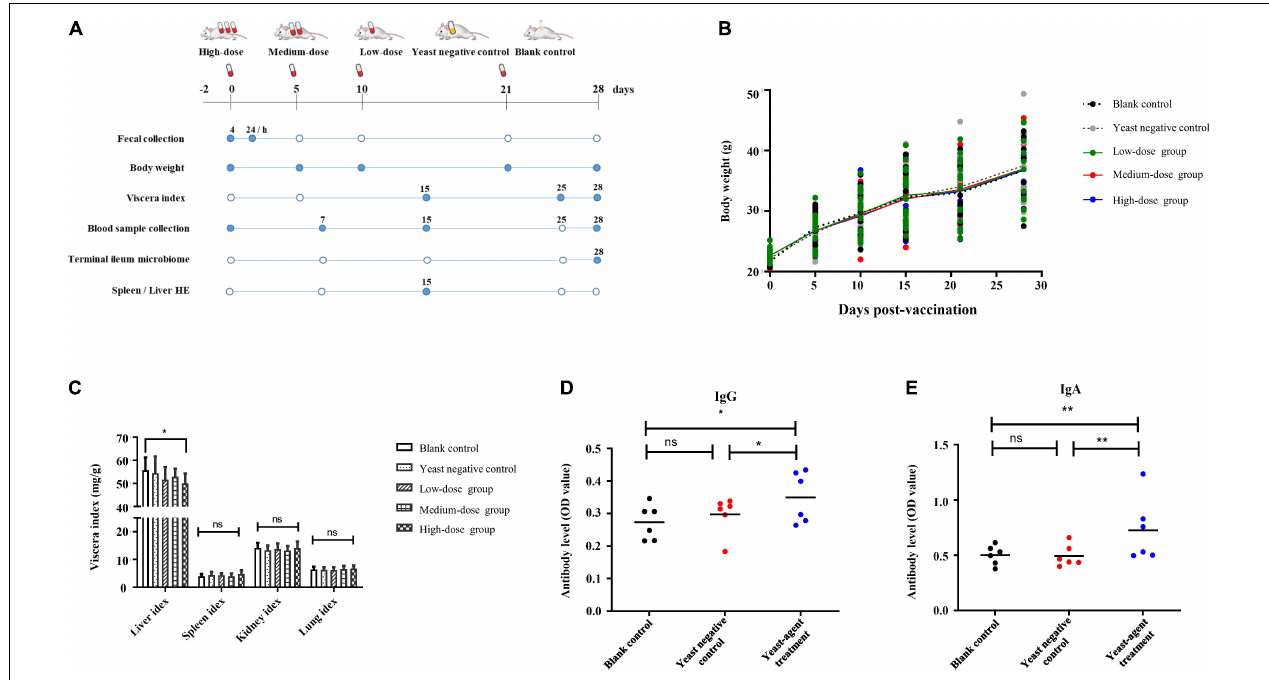
FIGURE 3 | Study overview and effects of yeast agents on body weight, viscera index, and virus-specific antibody responses in vaccinated mice. (A) Study overview. A total of 100 mice were randomly divided into five groups and received the yeast agents at 0 − , 5 − , 10 − , 21 − , and 28-days intervals via oral gavage administration. As illustrated in the diagram, samples were collected at regular intervals (filled circles). (B) Body weights were measured at 0 − , 5 − , 10 − , 21 − , and 28-days intervals. (C) Also, organ weight was measured at day 28, taking 12 mice per group. Viscera index = (Total weight of viscera/total body weight before removing the viscera) * 100. (D,E) Vaccinated mice were fed with ST1814G-S (RBD-FP) four times at 5 − , 5 − , 11 − , and 7-days intervals. The titers of spike-specific total immunoglobulin G (IgG) (D) and immunoglobulin A (IgA) (E) antibodies in serum were evaluated by ELISA. Serum samples were collected at the end of four immunization times. The individual animal response to each antigen was evaluated in triplicate and is depicted as the mean of the absorbance values at 450 nm minus the mean absorbance of cognate pre-immunization serum. The antigen-specific titers among the treatment groups were compared using ANOVA, followed by Tukey’s multiple-comparison test. Error bars show the standard deviation between triplicates. The mean and standard error of antibodies of each group is shown. * P = 0.05 and ** P =